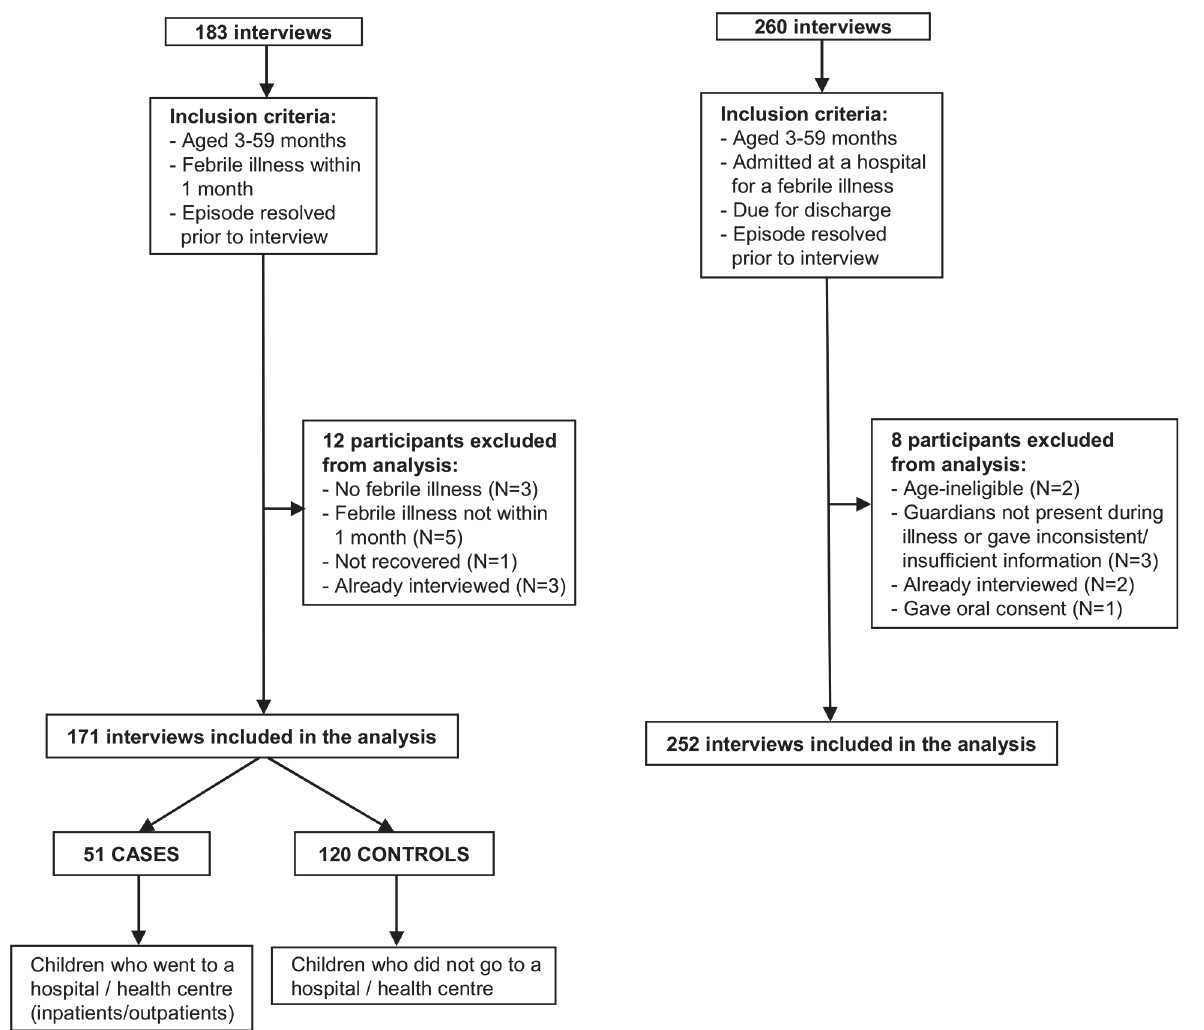
Fig 1. Community interviews — Cases and Controls (A); Hospital interviews